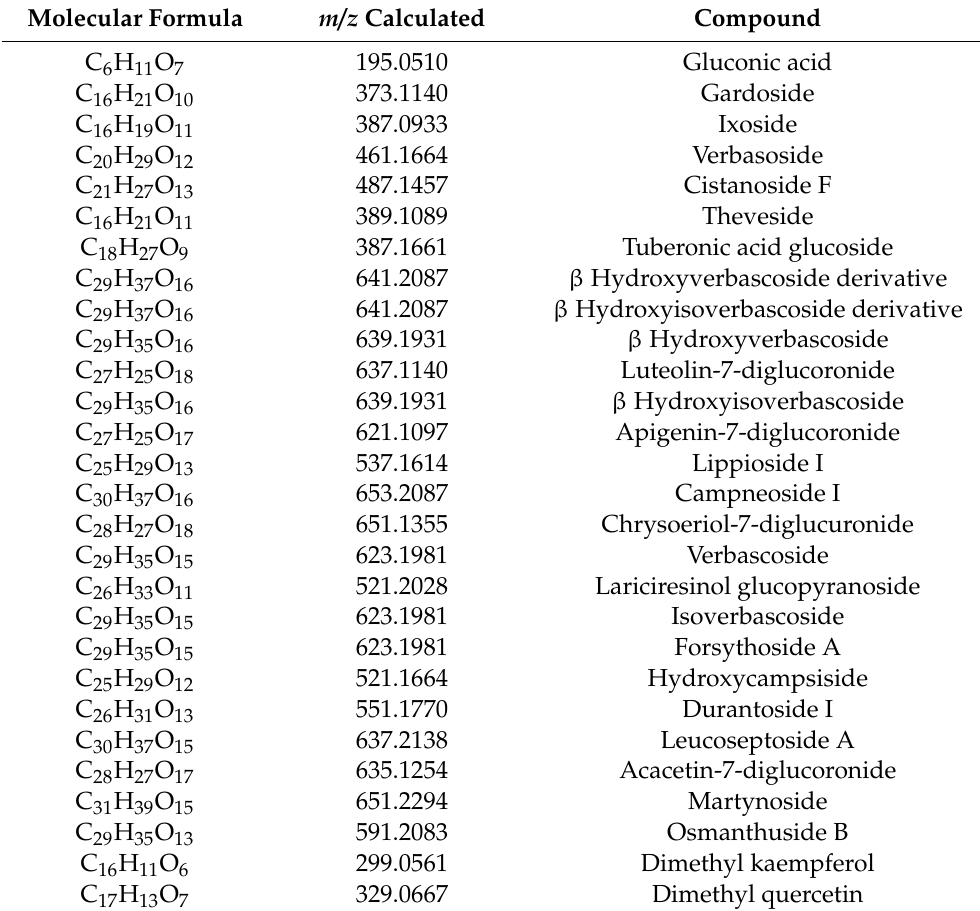
Table 4. Major compounds tentatively identified in L. citriodora leaves by high-performance liquid chromatography coupled to mass spectrometry